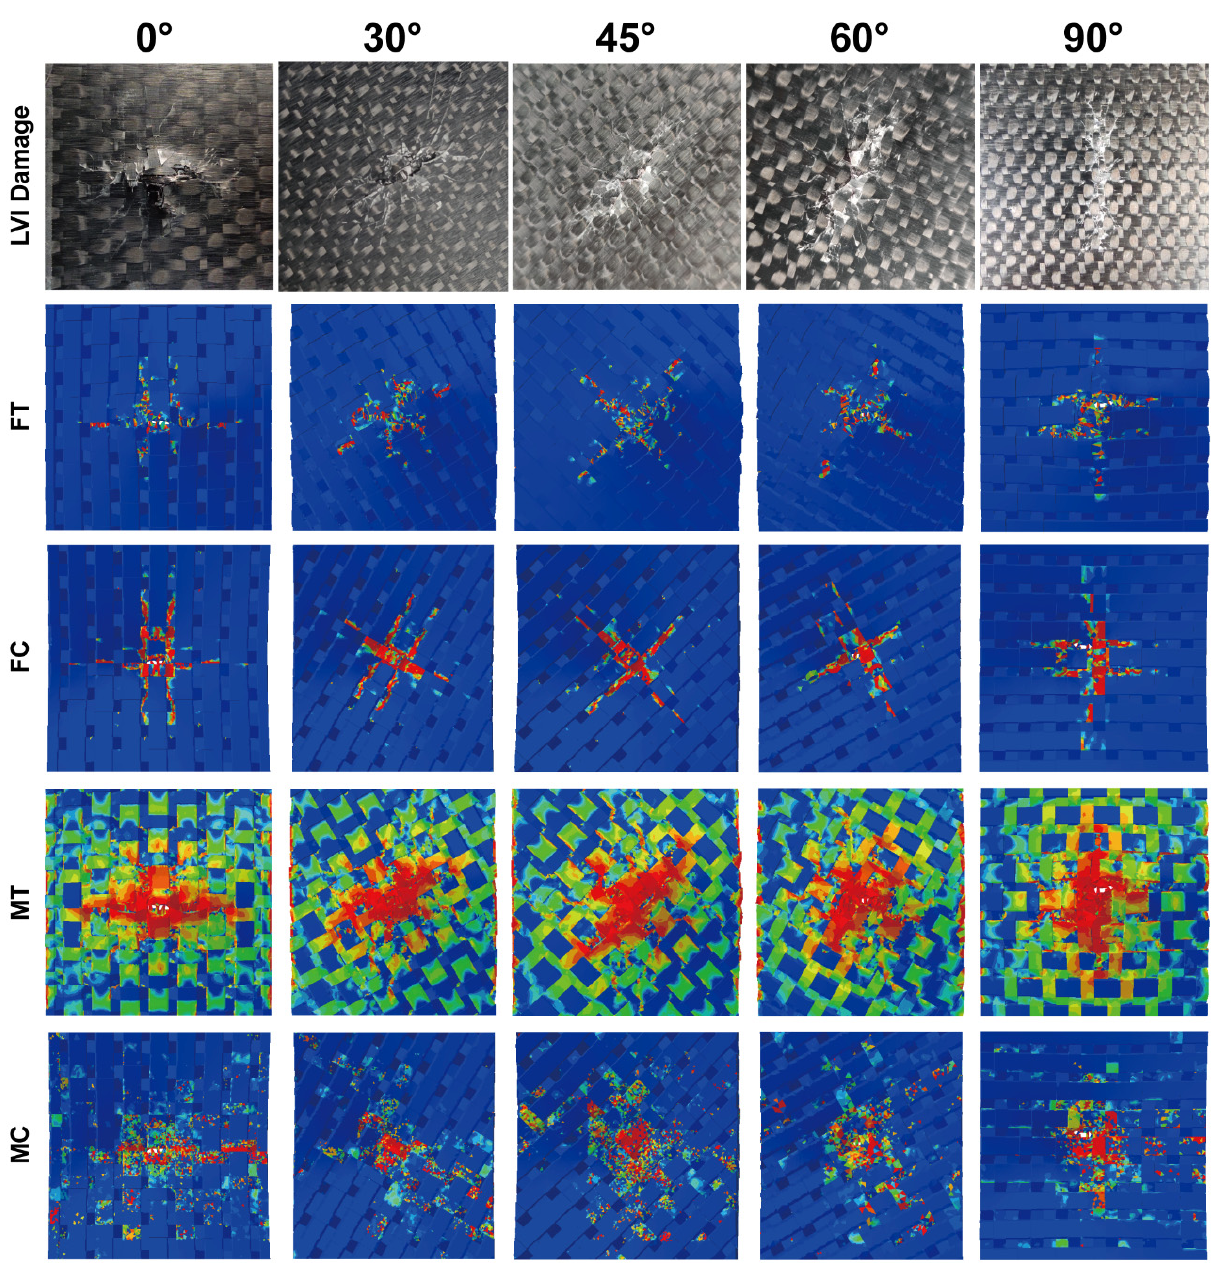
Figure 5. Surface damage morphology under 47.6 J of impact energy obtained by LVI tests and FEM: fiber tensile damage (FT), fiber compressive damage (FC), matrix tensile damage (MT), and matrix compressive damage (MC).